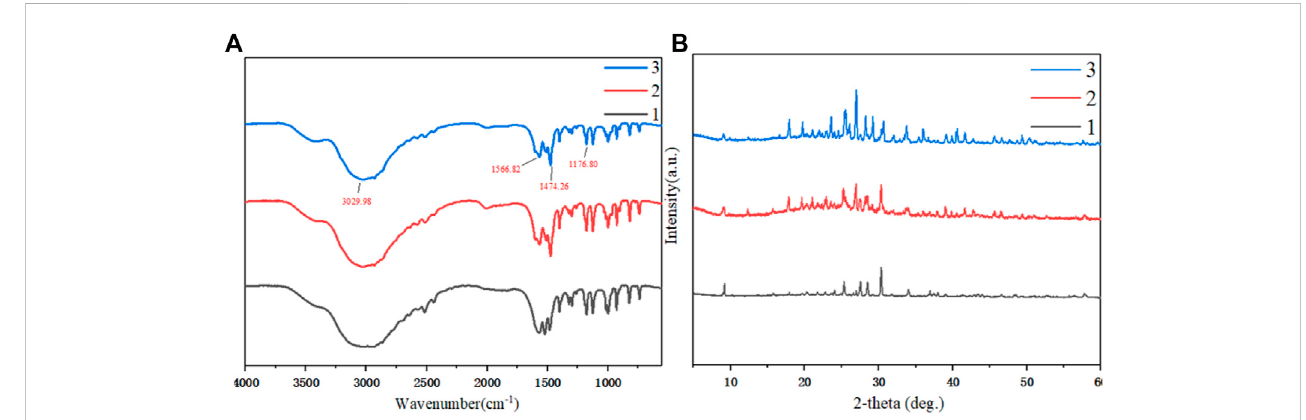
FIGURE 9 (A) Infrared spectrum characterization of cooling crystallization products from three different raw materials (B) PXRD characterization of cooled crystalline products from three different raw materials 1. Crystallization of PHF 2. Crystallization of PHDF 3. Crystallization of